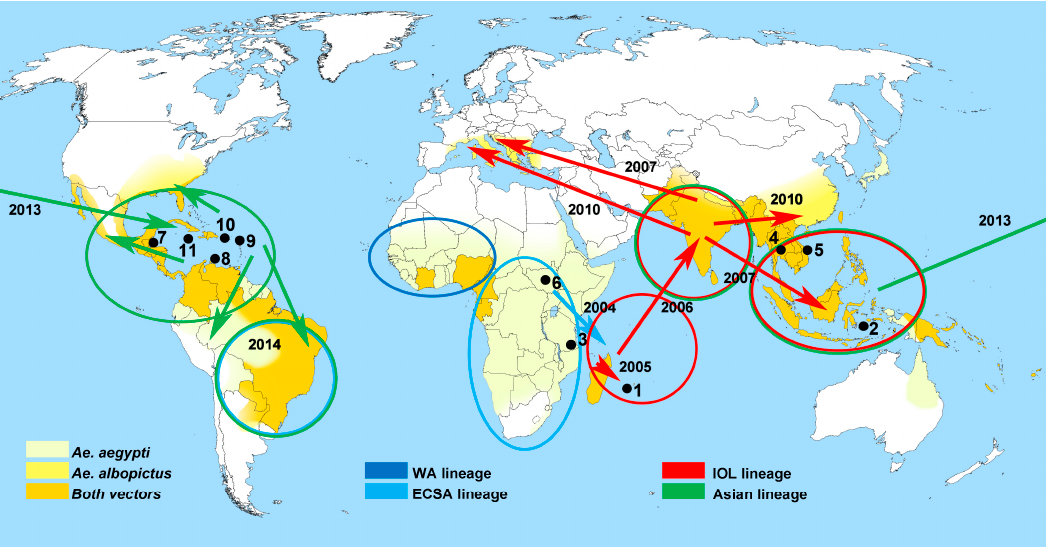
Figure 1. Countries or regions with chikungunya virus (CHIKV) endemicity and/or outbreaks mentioned in this review in the order of appearance (black dots and numerals 1–11). 1. Réunion; 2. Malay Archipelago; 3. Makonde/Tanzania; 4. Thailand; 5. Vietnam; 6. Southern Sudan; 7. Belize; 8. Curaçao; 9. Saint Martin; 10. Puerto Rico; 11. Jamaica. Arrows with year dates indicate global spread of CHIKV as described by Young, 2018 [7]. Map colorings show infestations of countries and areas with relevant arthropod vectors according to Rezza and Weaver, 2019 [8]. Information on CHIKV lineages were adapted from Weaver and Lecuit, 2015 [4]. Map template source: Petr Dlouhý, Wikimedia Commons.